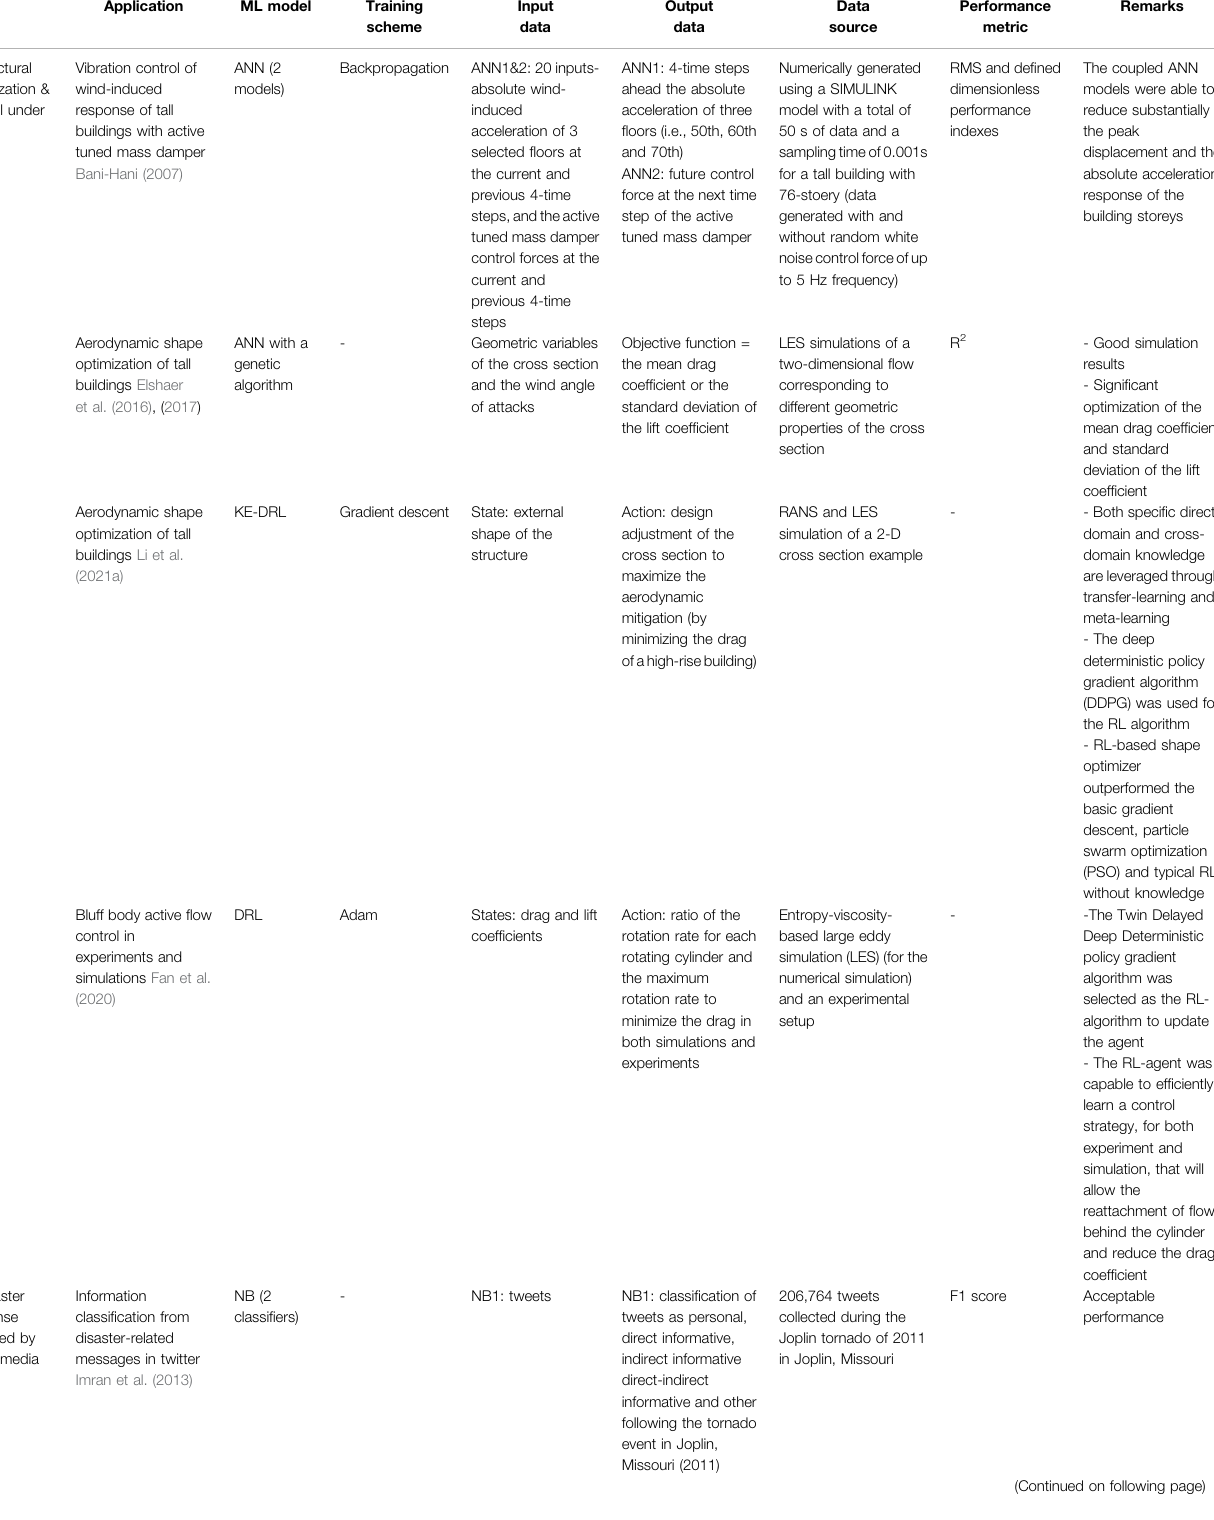
TABLE 7 | Summary of ML applications for mitigation and response.